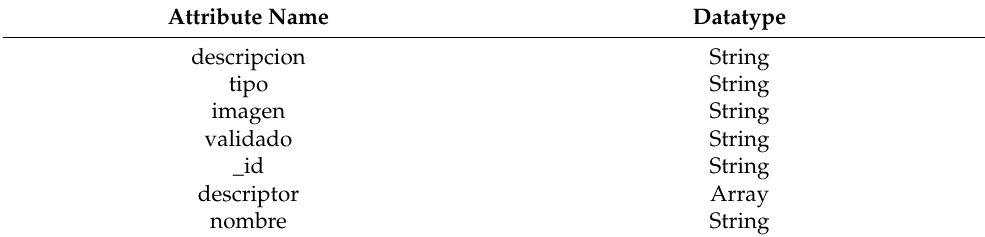
Table 4. Attributes of the multimedia_records